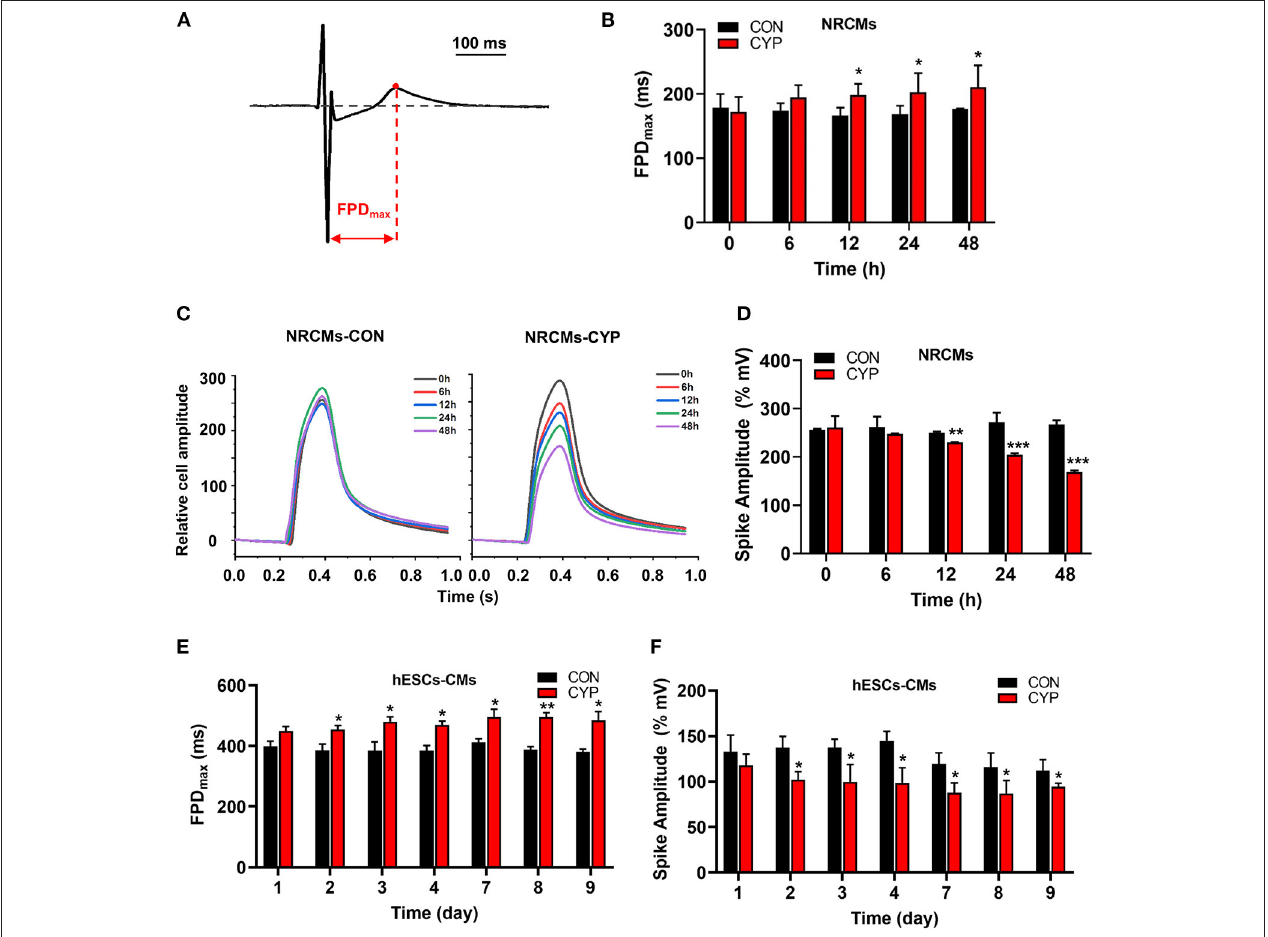
FIGURE 1 | CYP increased the field potential duration (FPD) and decreased contractile amplitudes of cardiomyocytes. (A) Schematic of FPD of cardiomyocytes. (B) The FPD analysis of NRCMs with 500 µ mol/L of CYP at 0, 6, 12, 24, and 48h. (C) Representative images of the relative cell amplitude of NRCMs treated with solvent control (CON) or CYP. The data were shown as the mean of triplicate experimental wells. (D) The cell amplitude analysis of NRCMs treated with 500 µ mol/L CYP at 0, 6, 12, 24, and 48h. The FPD (E) and cell amplitude (F) analysis of hESCs-CMs treated with 500 µ mol/L CYP at 1, 2, 3, 4,7,8, and 9 days. The data are shown as the mean ± SE, n = 3. * P < 0.05, ** P < 0.01, *** P < 0.001 vs.